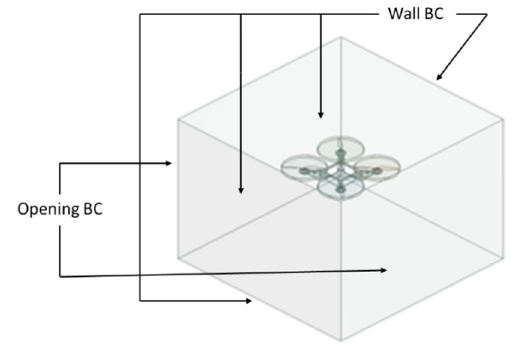
Figure 25. UAV with Computational domain.